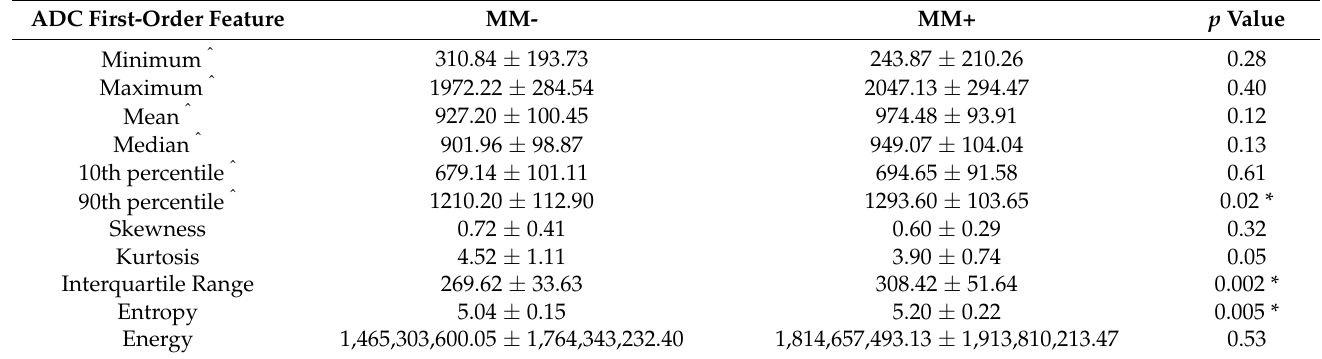
Table 4. Association of ADC first-order features and the presence of metachronous